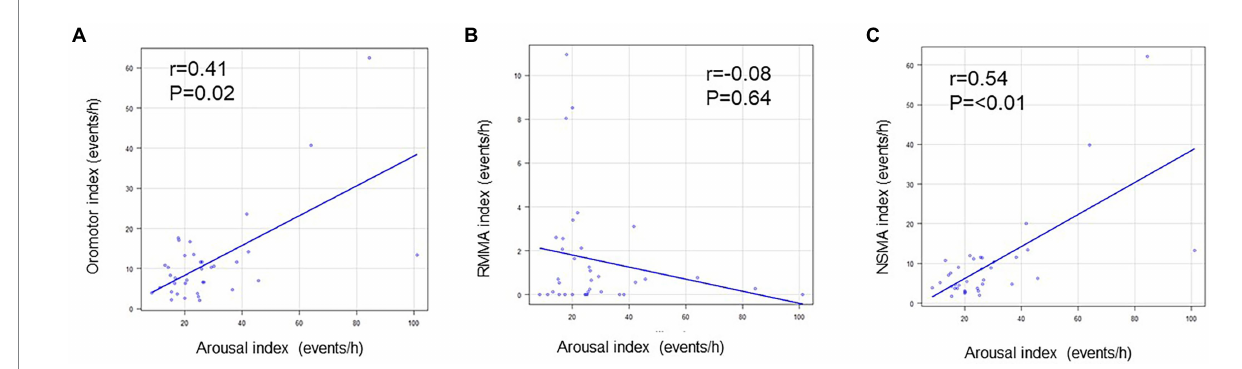
FIGURE 5 Relationships between arousal and oromotor events. (A) Relationship between the arousal index and oromotor index. (B) Relationship between the arousal index and the RMMA index. (C) Relationship between the arousal index and NSMA index. The arousal index positively correlated with the oromotor index and NSMA index (Spearman’s correlation